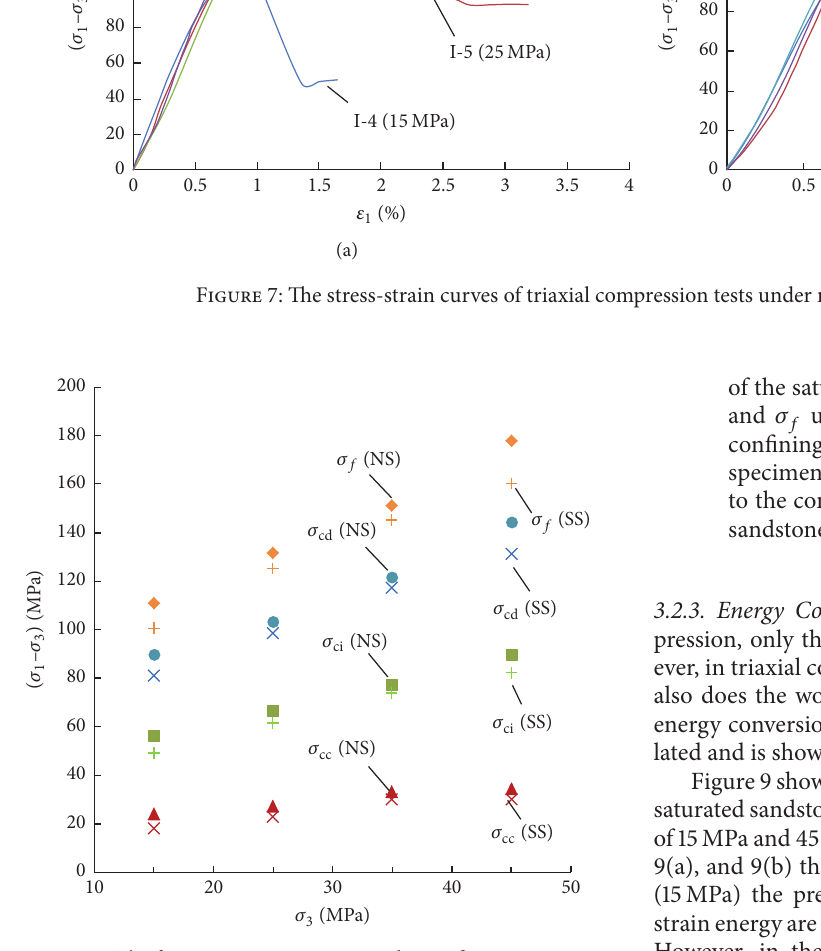
only slightly higher than those of the saturated ones under all confining